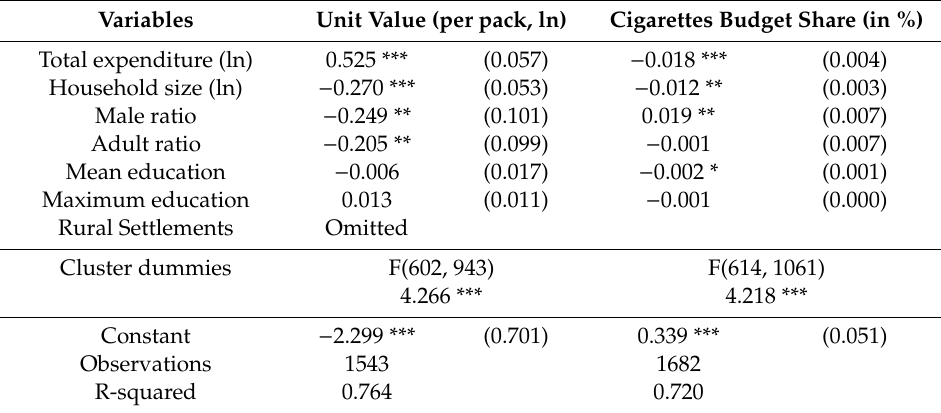
Table 2. Regression